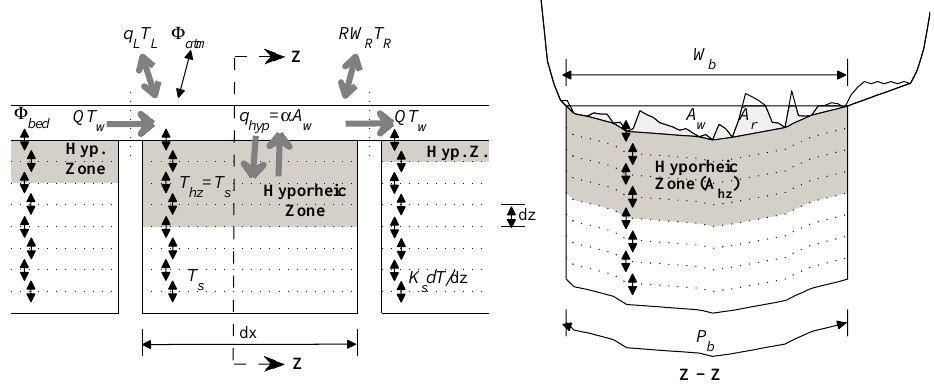
Fig. 3. Schematic of the 1-D advection-dispersion model with transient storage. The grey arrows are water fluxes, the black arrows are energy fluxes. q hyp is the hyporheic exchange flux per unit stream length, given by αA w . The cross-sectional area of water and rock clasts is given by A b = A w + A r , where A r is the cross-sectional area of the rock clasts. (Figure is adapted from Westhoff et al., 2011)